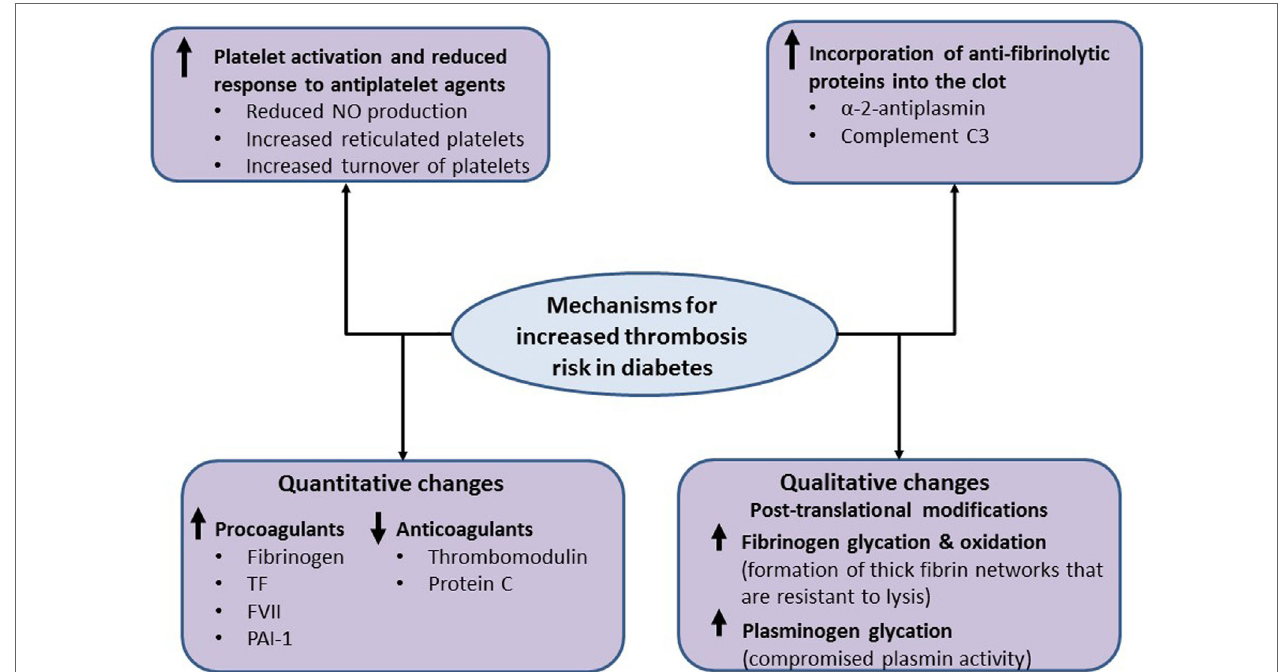
FigURe 3 | Mechanistic pathways for increased thrombosis risk in diabetes. The metabolic changes in diabetes are associated with increased platelet activation, secondary to reduced nitric oxide (NO) production, an increase in reticulated platelets and increased platelet turnover, which can be only partially controlled by antiplatelet therapy. Diabetes is also associated with increased plasma levels of procoagulants and the antifibrinolytic protein levels, including fibrinogen, tissue factor (TF), factor VII (FVII), and plasminogen activator inhibitor-1 (PAI-1) as well as decreased levels of anticoagulants, including thrombomodulin and protein C. Moreover, qualitative changes in coagulation proteins, including increased oxidation and glycation of fibrinogen, have also been reported in diabetes, which result in the formation of thick fibrin networks that are resistant to lysis. Increased glycation of plasminogen compromises conversion to plasmin and alters protein activity. Finally, increased incorporation of antifibrinolytic proteins, such as α 2-antiplasmin and complement C3, into the clot impairs fibrinolysis and may represent a new therapeutic approach to reduce thrombosis risk in